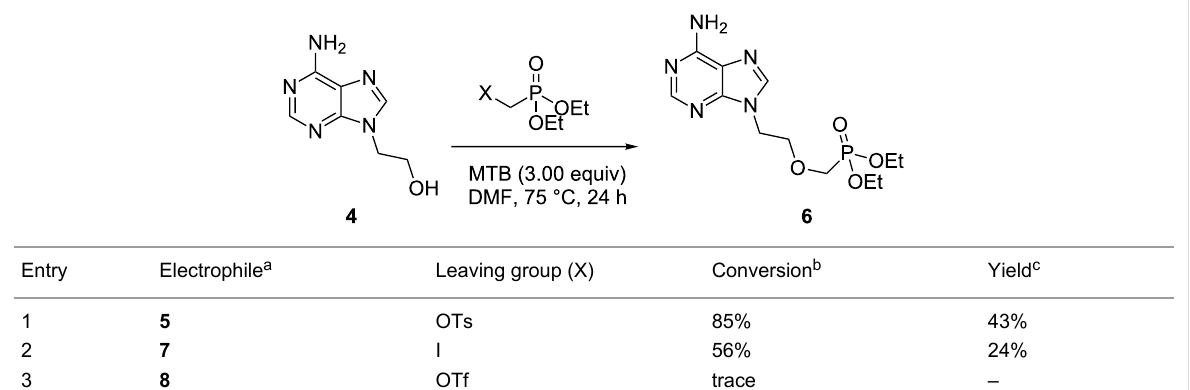
Table 1: Impact of the leaving group on in situ conversion of 4 to 6 .